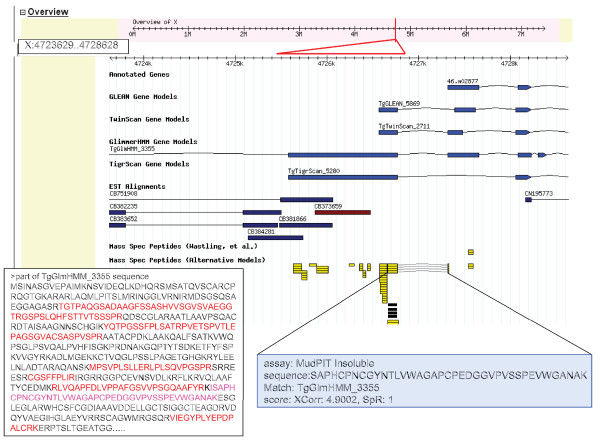
Peptide evidence indicating an ORF where release4 annotation does not predict an ORF. The position of ORF X-3-4725402-4726856 in the genome scaffold is indicated by a red line on the grey track at the top of the figure and this region is expanded below, the red triangle demarking the ORF length. Different gene annotation models are presented one above the other bellow the scaffold. Predicted exons are indicated as blue boxes, linked by zigzag lines to indicate the position of exon/intron boundaries. The predicted sequence for TgGlmHMM_3355 is shown as an insert; sequence for which there is matching peptide evidence is shown in red. The peptide that spans an intron-exon boundary is shown in purple. Peptides aligning with this region are shown in yellow and the detailed MS information for one is shown, including the predicted sequence. Peptides that align with the release4 or alternative gene annotations are indicated on different lines. ESTs are shown as dark blue or brown boxes.